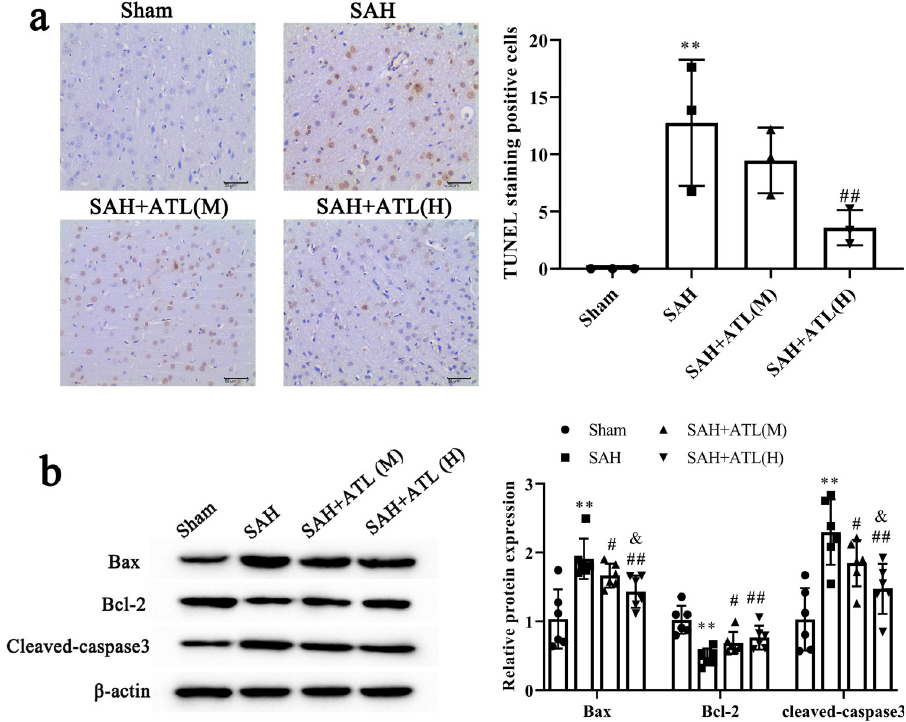
Fig 3. Effects of ATL on neuronal apoptosis at 72h after SAH. (a) Representative images of TUNEL staining of the ipsilateral temporal cortex at 72 h after SAH and quantitative analysis. Scale bar = 50 μ m. n = 3, the number of images analyzed. (b) protein expression of Bax, Bcl-2, and cleaved-Caspase 3 among each group. n = 6. Data are represented as the mean ± SD. �� p < 0.01 vs. sham group; # p < 0.05 and ## p < 0.01 vs. SAH group; & p < 0.05 and && p < 0.05.